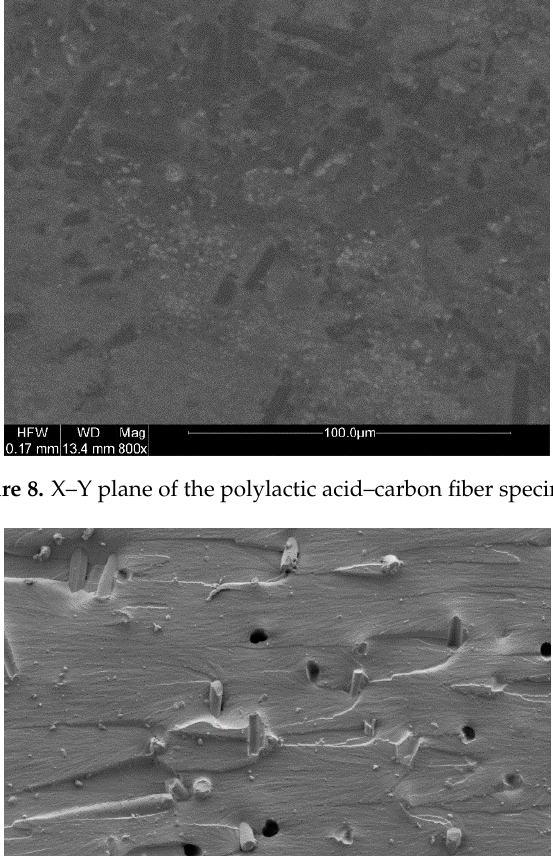
Figure 7. Friction coefficient of the polylactic acid–carbon fiber (PLA–CF) specimens. 174